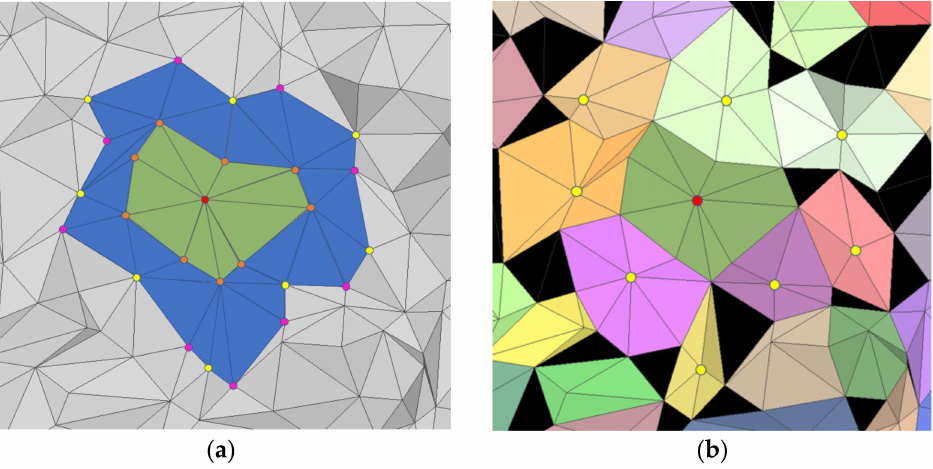
Figure 2. The 1-ring patch model generation process from new seeds generation ( a ) to new patches generation ( b ). Patches are distinguished by different